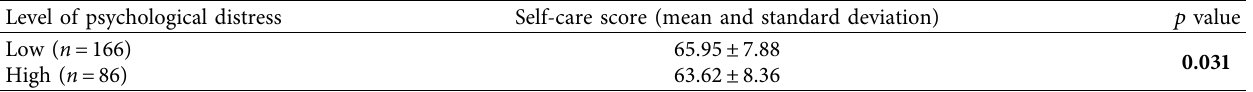
Table 5: The relation between the level of psychological distress and self-care score. A p value < 0.05 was considered